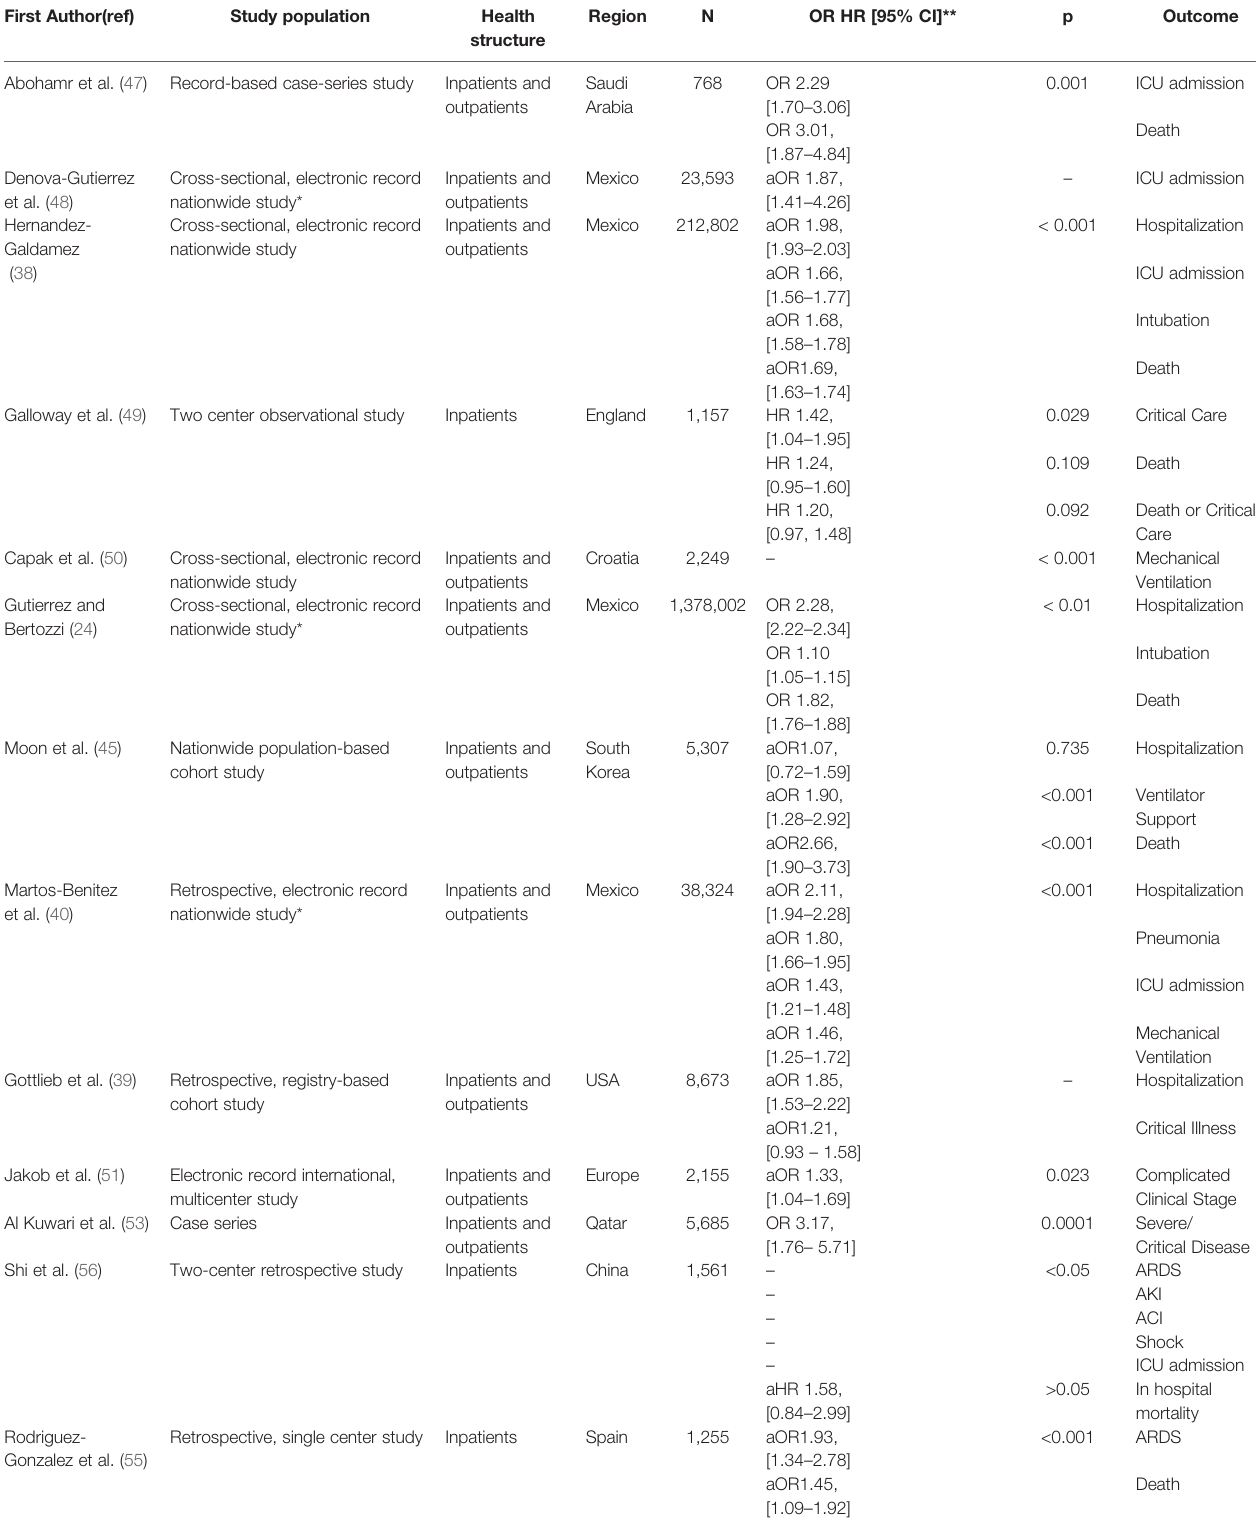
TABLE 1 | Studies that highlight diabetes mellitus as a risk factor for mortality and/or complications from COVID-19